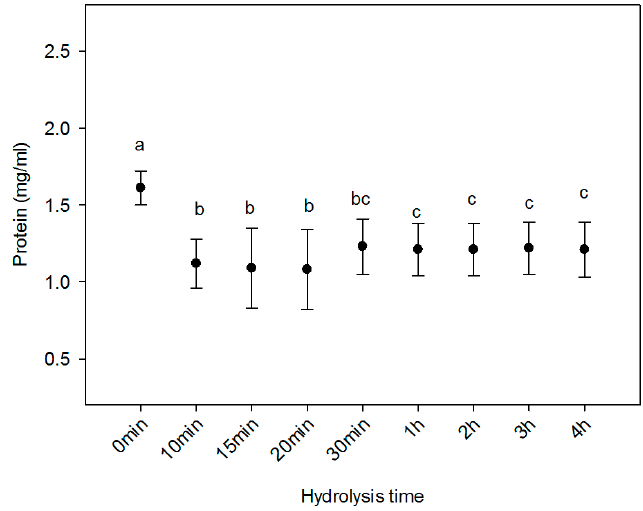
Figure 1. Protein concentration for different hydrolysis times in ovine collagen. Different letters represent the average of three replicates and indicate significant difference at p ≤ 0.05.